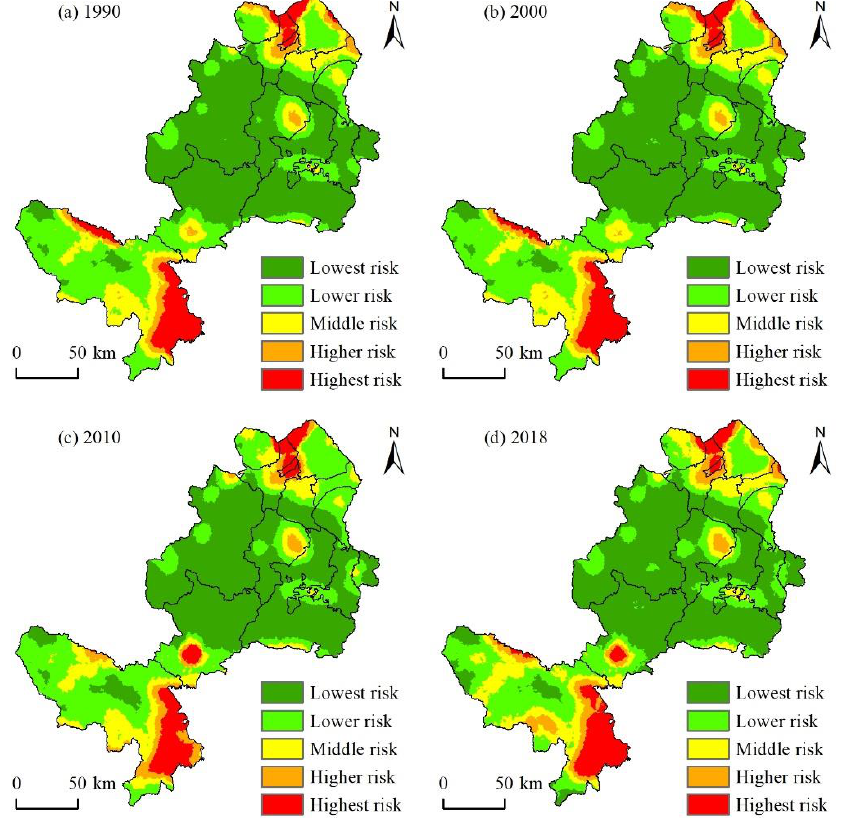
Figure 5. Spatial distribution map of landscape ecological risk. ( a ) 1990; ( b ) 2000; ( c ) 2010; ( d ) 2018.